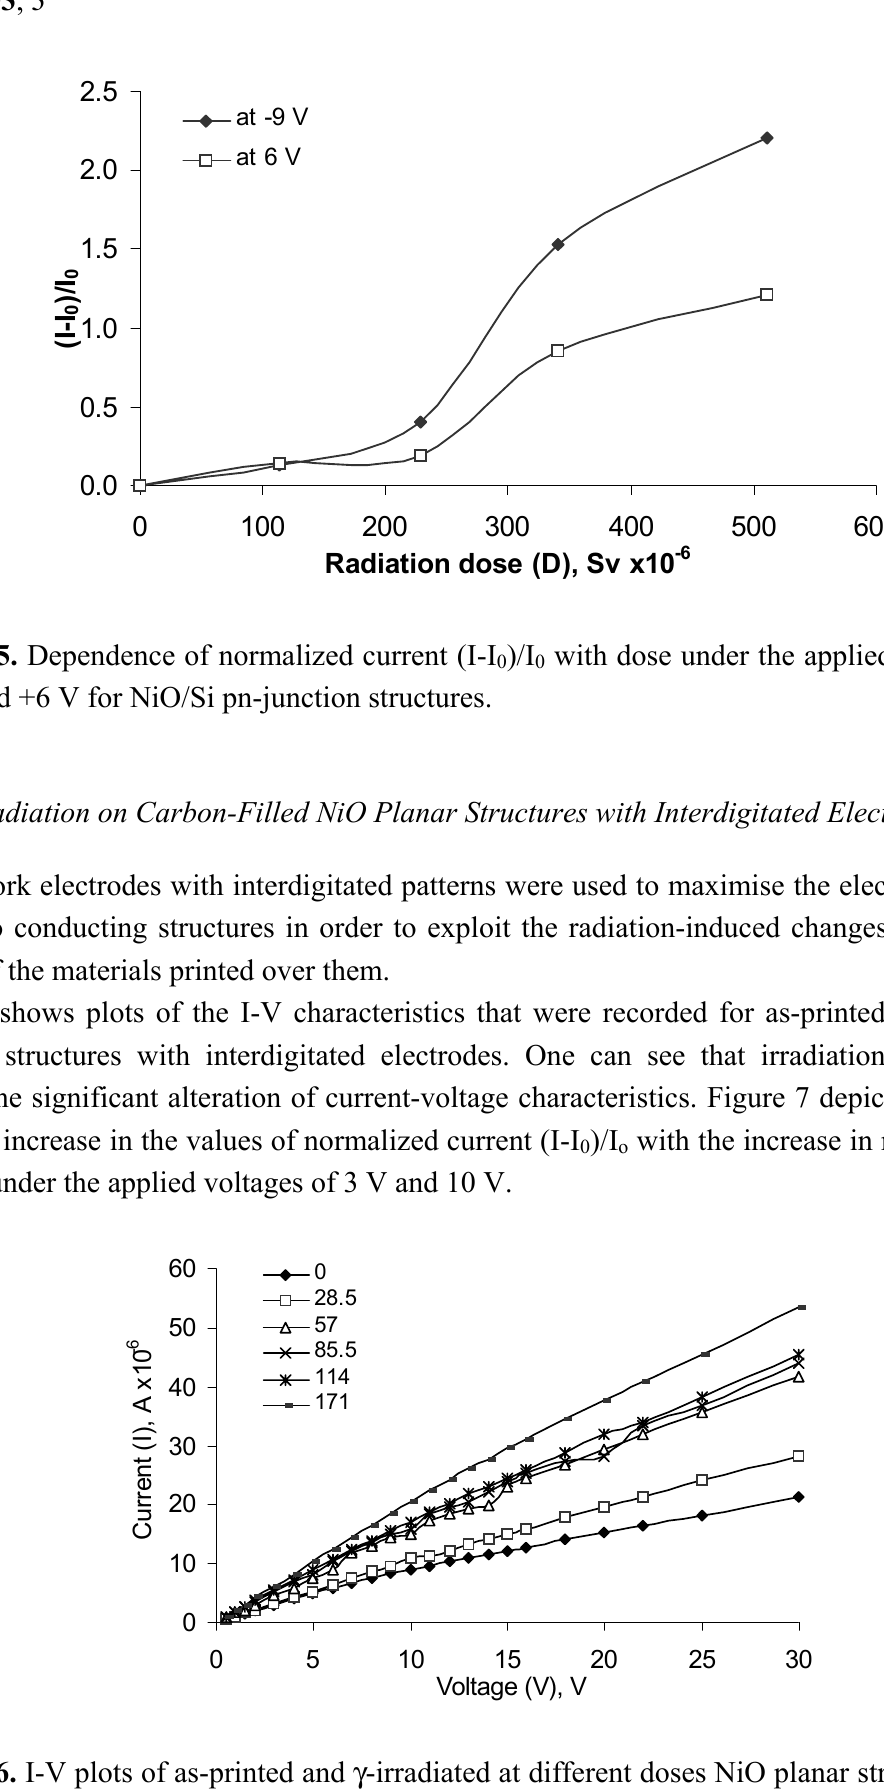
Figure 6. I-V plots of as-printed and γ -irradiated at different doses NiO planar structures with interdigitated